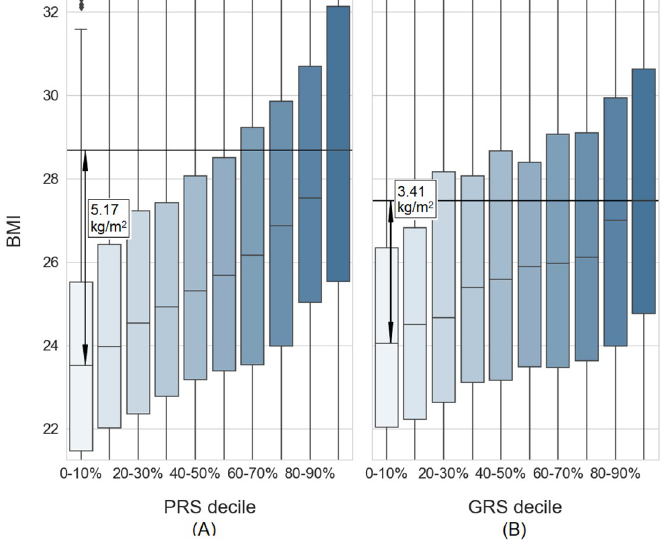
Fig 2. BMI distribution of individuals, stratified by genetic risk. (A): Individuals stratified by BMI PRS deciles. (B): Individuals stratified by BMI GRS deciles. Both graphs are plotted in the same scale and cut at 10 th / 90 th percentiles on the y-axis. Box plots represent the median and 25 th / 75 th percentiles. Whiskers are set at 1.5 IQR. Both graphs show BMI, unadjusted for age and sex. Adjusted BMI residuals and outliers are available at Online Supplementary.